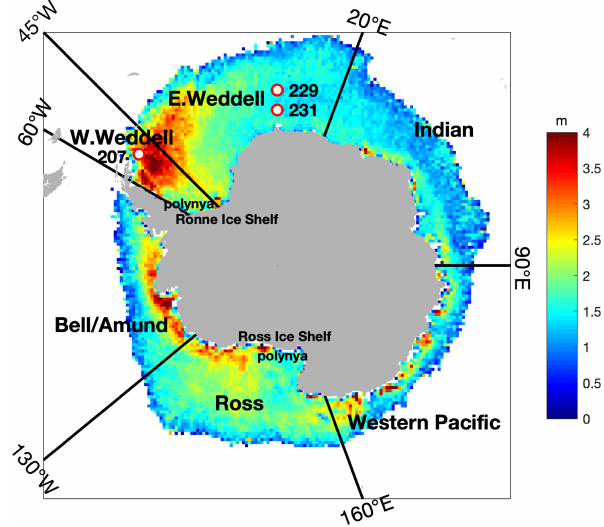
Figure 2. Map of the different sectors referred to in the study. The background is the average of the September sea ice thickness from Envisat during 2003–2011 with 50km grid size. Each sector and the two ice shelf polynyas are indicated in the figure. The circles and the corresponding numbers refer to the sites of the ULSs. The white grid cells stand for areas with sea ice concentration of less than 70% or missing